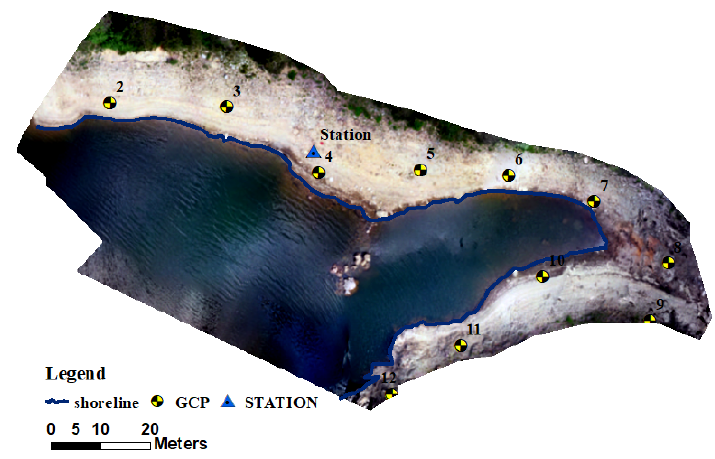
Figure 6. An orthophoto representing the merged point clouds in a single one. Table 3. GCPs in the merged point cloud and final error in correspondence with the CPs. The coordinates are expressed in